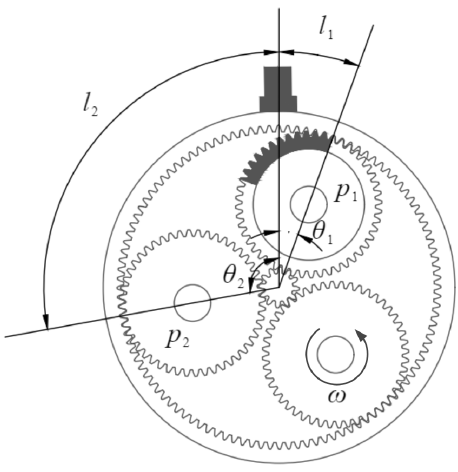
Figure 6. Objective planet gear is at the boundary of capturing of